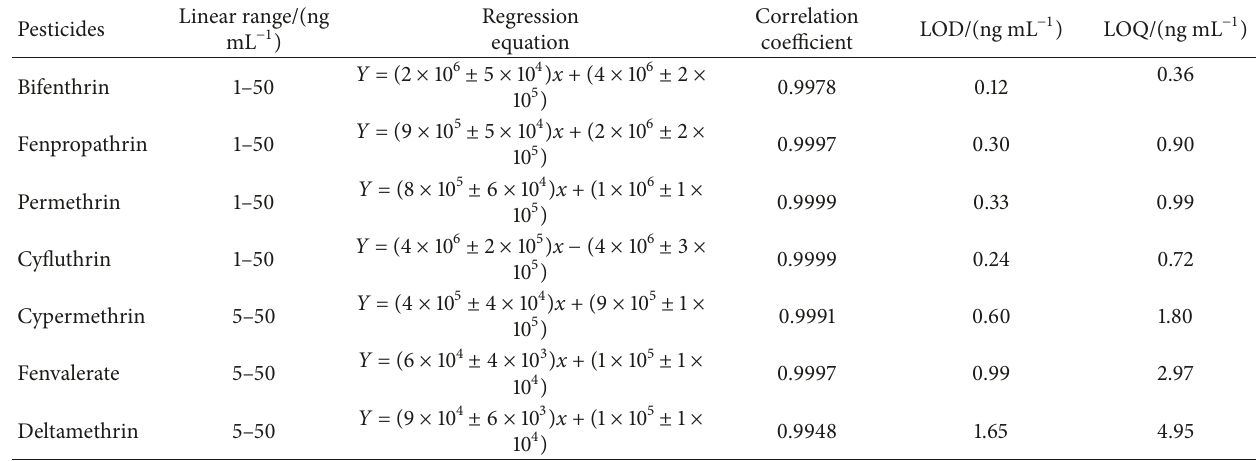
Table 2: The linear ranges, correlation coefficients, LODs, and LOQs of the